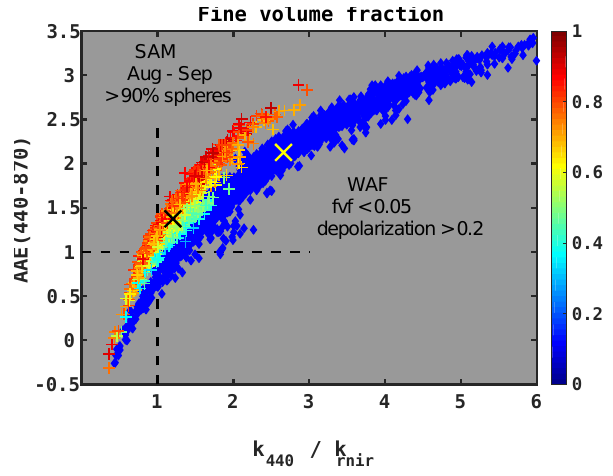
Figure 5. Absorption Ångström exponent vs. the k 440 /k rnir imag- inary refractive index ratio, color-coded with the fine volume frac- tion. Upper branch of “ + ” symbols is the South American sites dur- ing the biomass burning season when more than 90% of the re- trievals are spheres; the lower branch of diamond symbols is dust at the West African sites when the fine volume fractions are less than 0.05 and the linear depolarization ratios are greater than 0.2. Medians of the two branches are denoted by the “ × ” symbols.